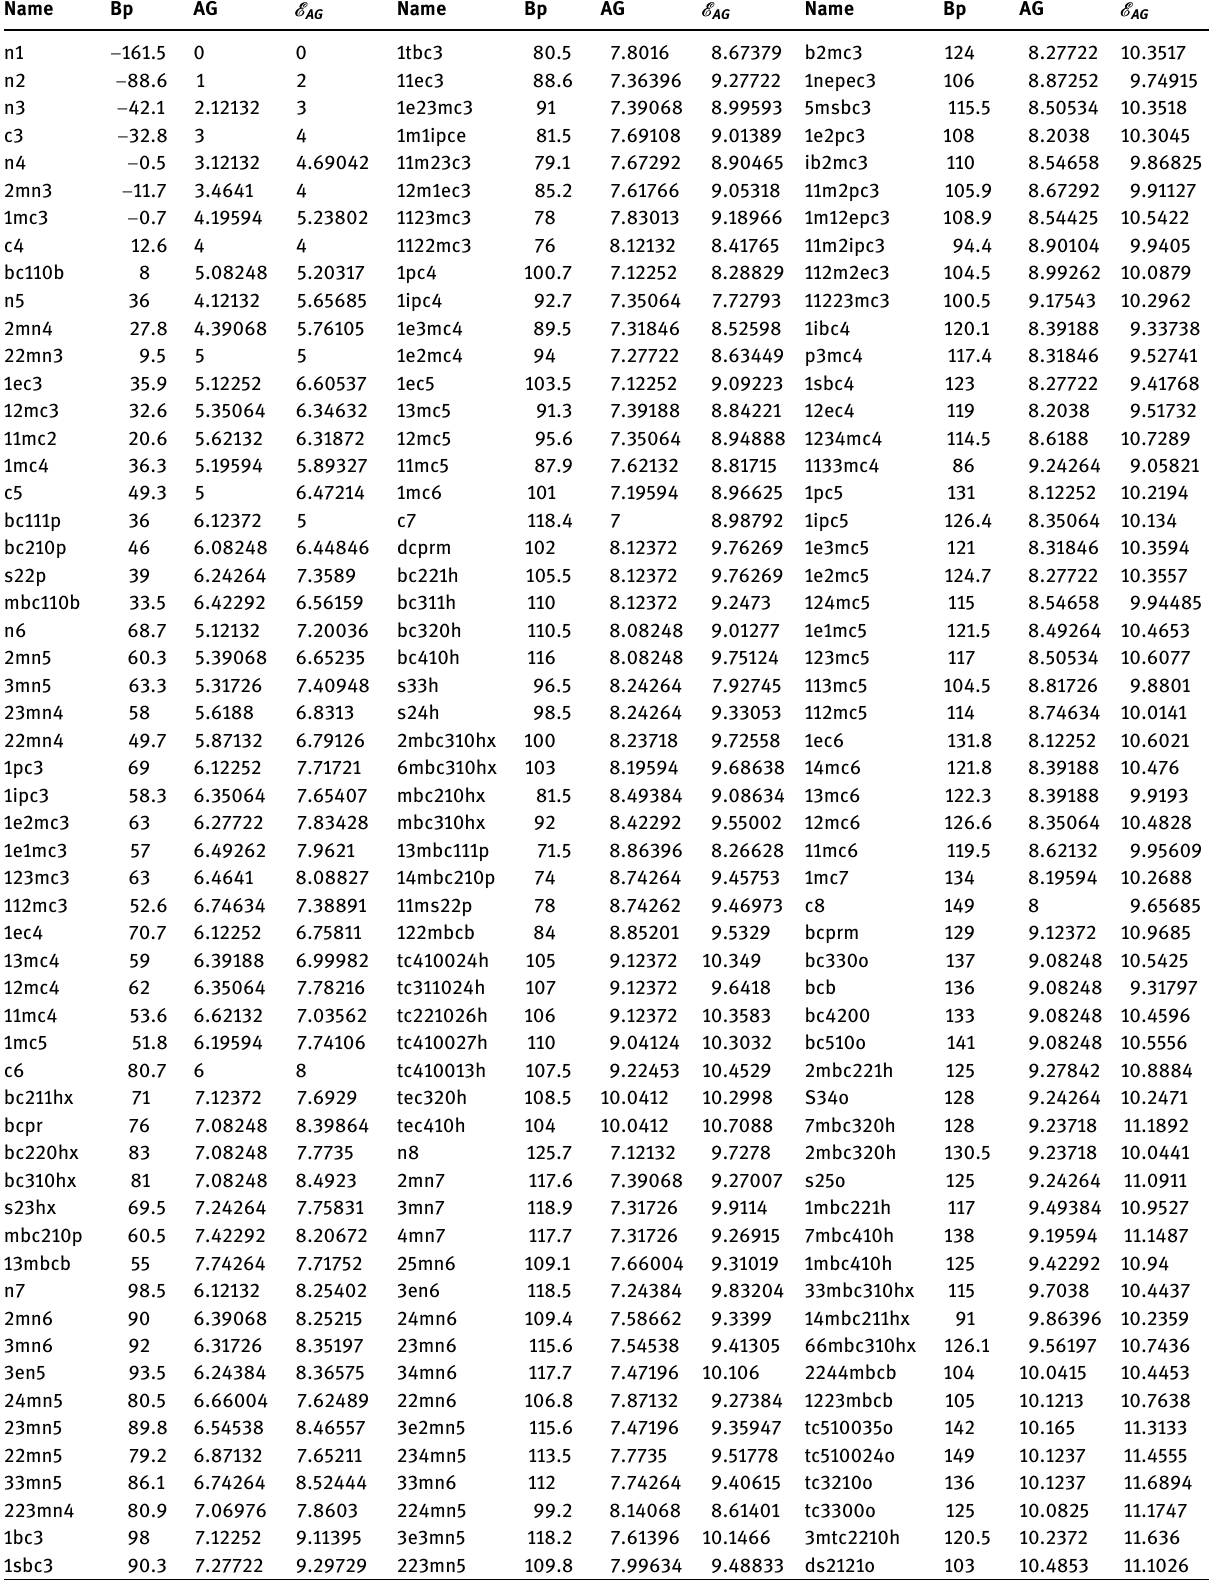
Table 1: Boiling point, AG index, and AG E energy of alkanes up to order